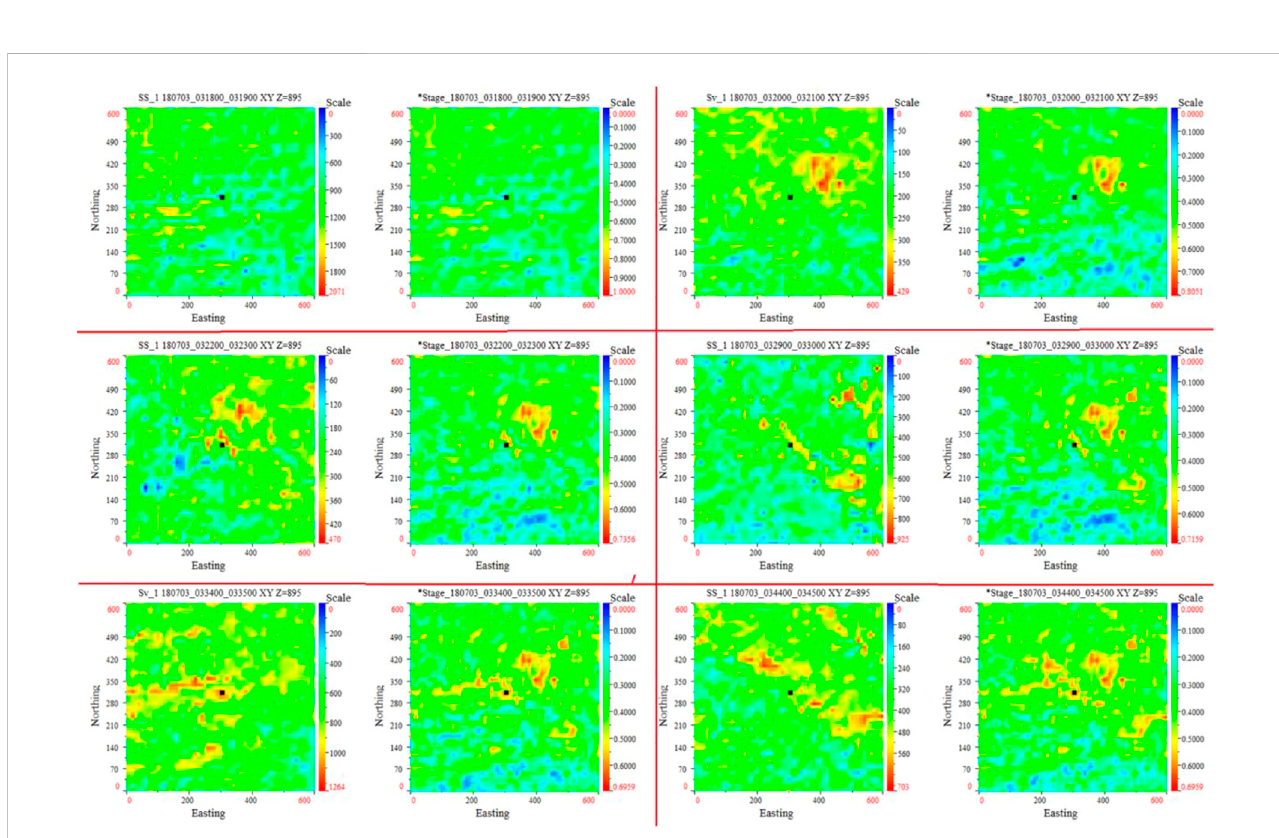
FIGURE 7 Cumulative diagram of important period of fracturing and the period to important period in the fracturing process of well